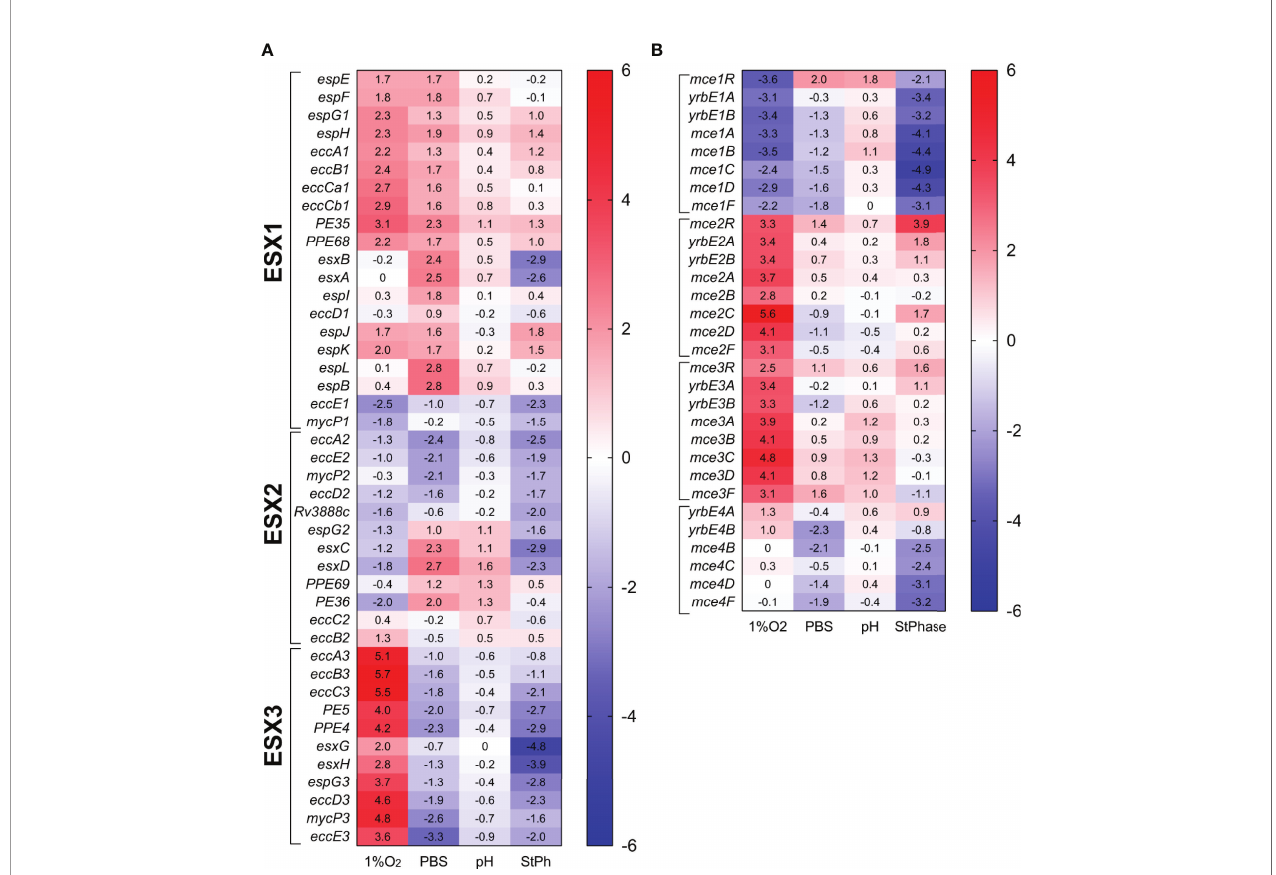
FIGURE 6 | Heat map of genes expression associated with the ESX systems (A) and the mammalian cell entry (mce) system (B) . The log2 fold change for each gene and condition is indicated in the